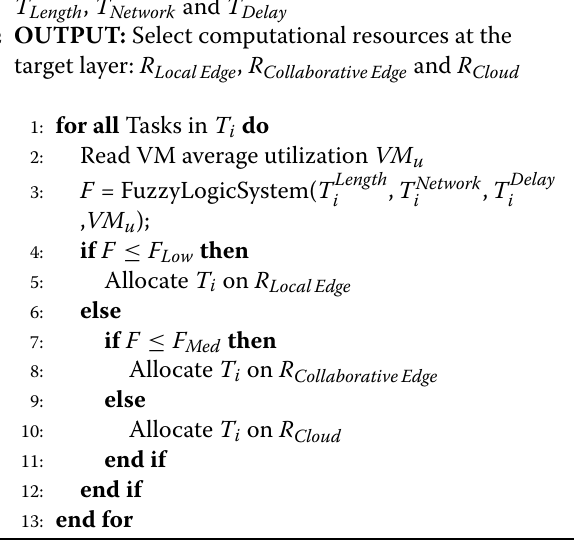
Algorithm 1: Fuzzy Logic for Offloading to the Target